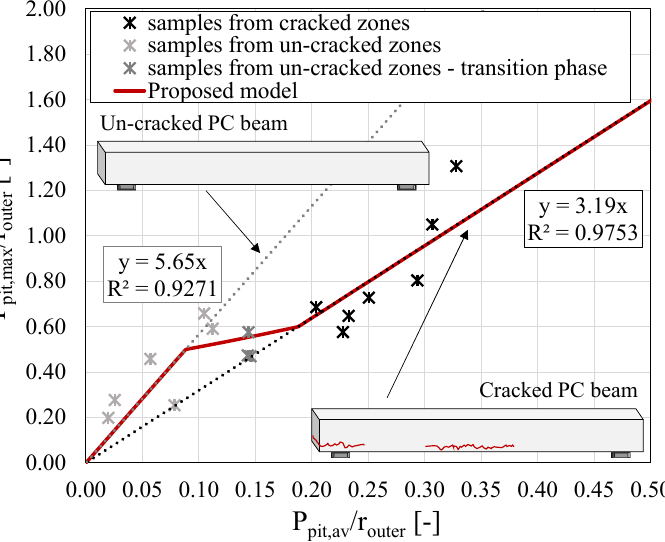
Figure 11. Correlation between dimensionless average and maximum penetration depth considering surface longitudinal cracks.